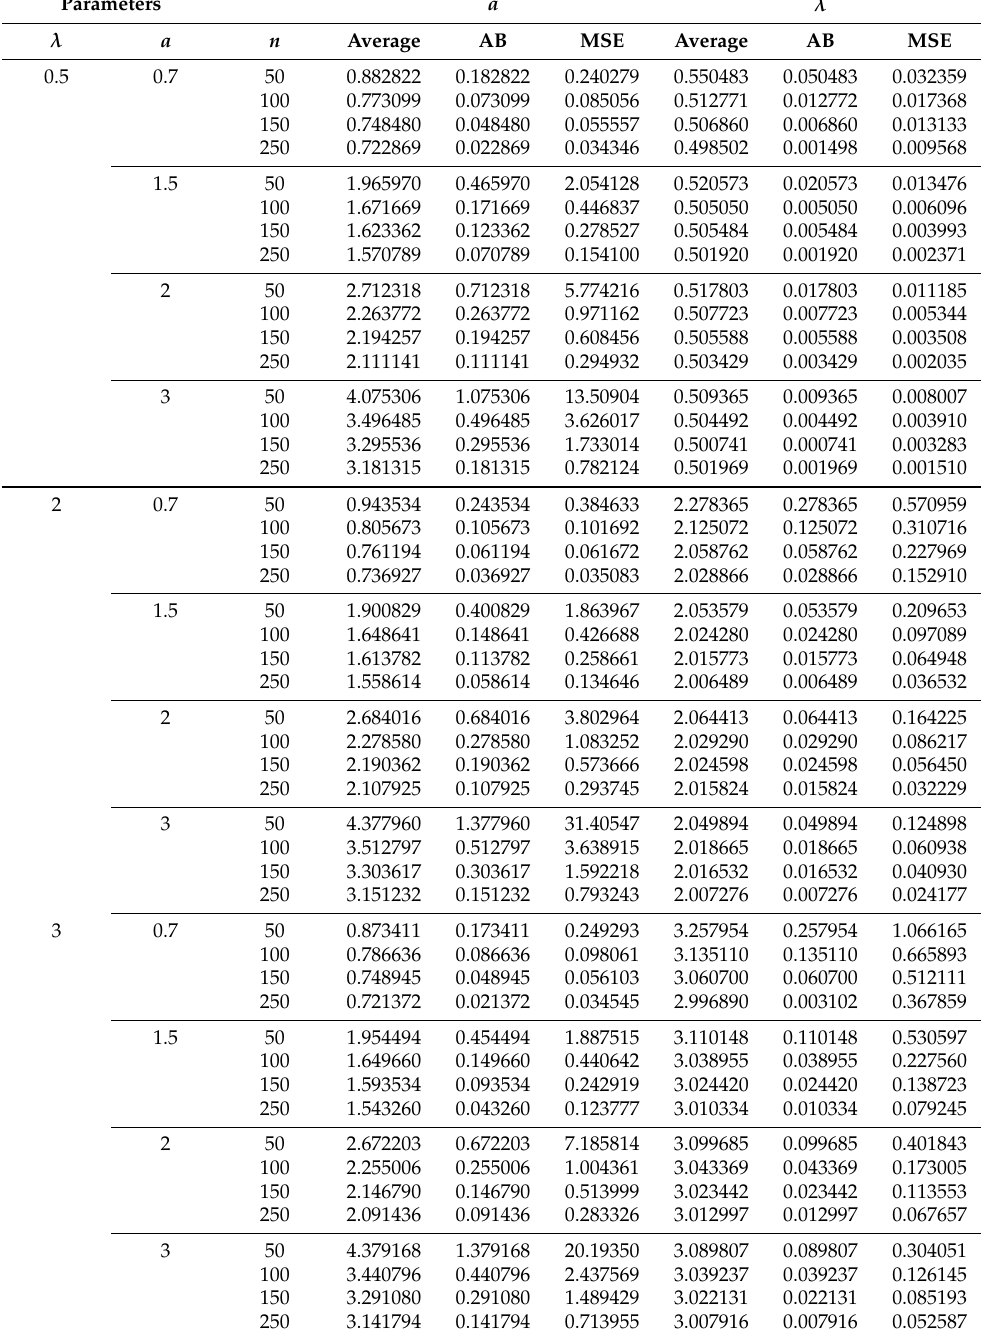
Table 1. Simulation results for the MPoE